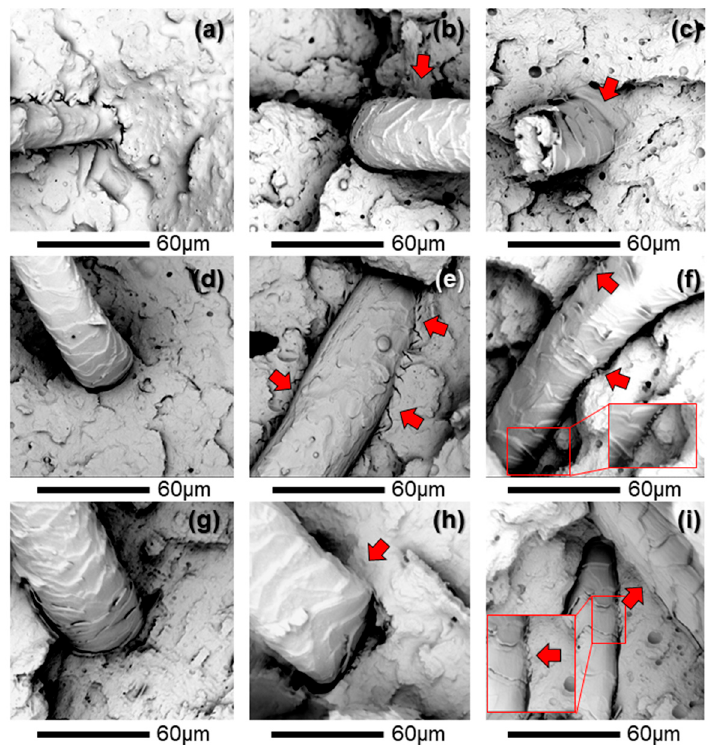
Figure 11. SEM images of ( a ) PLA/MLO-1W, ( b ) PLA/MLO-1W-1TVS, ( c ) PLA/MLO-1W-2.5TVS, ( d ) PLA/MLO-5W, ( e ) PLA/MLO-5W-1TVS, ( f ) PLA/MLO-5W-2.5TVS, ( g ) PLA/MLO-10W, ( h ) PLA/MLO-10W-1TVS, and ( i ) PLA/MLO-10W-2.5TVS.